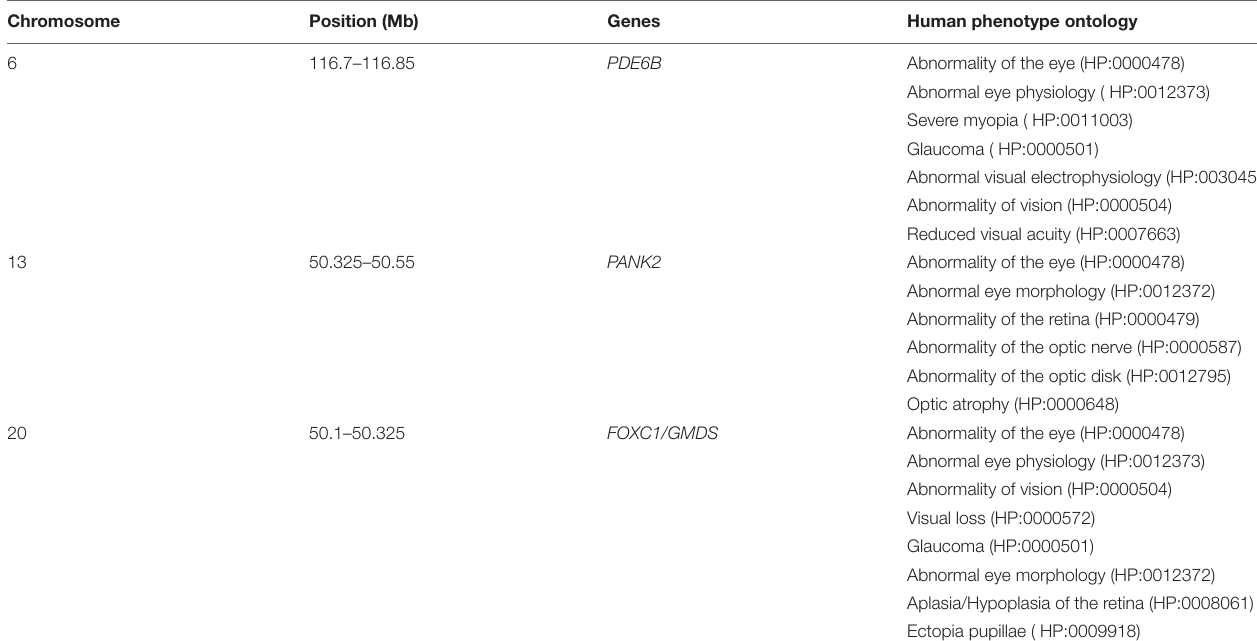
TABLE 2 | Human phenotype ontology (HPO) categories of the candidate genes related to vision function.